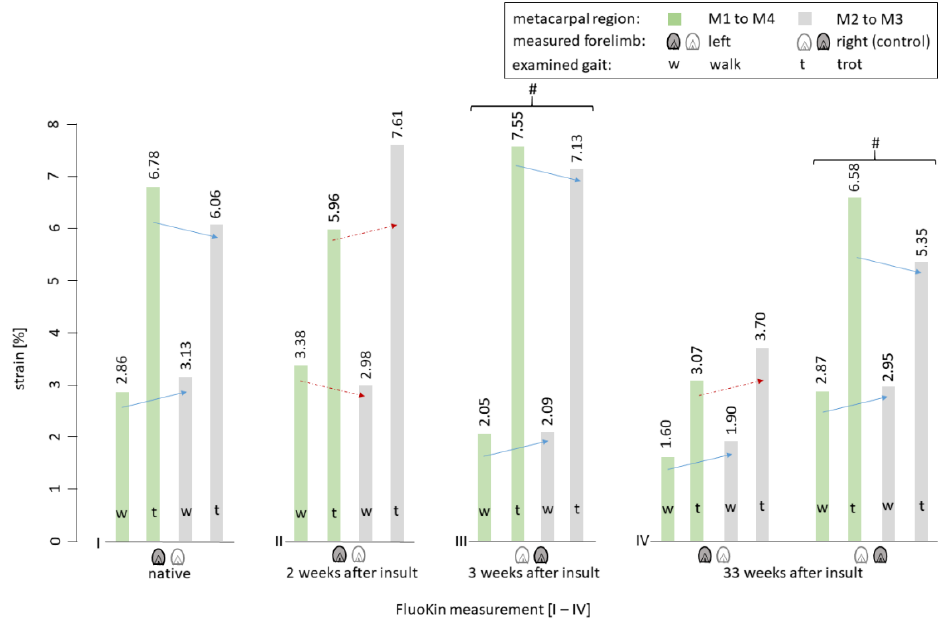
Figure 5. Bar graph of the measured strain of the SDFT of both forelimbs during walk and trot between the implanted tendon markers. Blue arrows: strain behavior in the sound SDFT (right forelimb and “native”). Red dotted arrows: alternated strain behavior compared to “native” and measurements within the right (sound) forelimb. # indicates nonsignificant differences between corresponding measurements in the right, not-insulted forelimb.